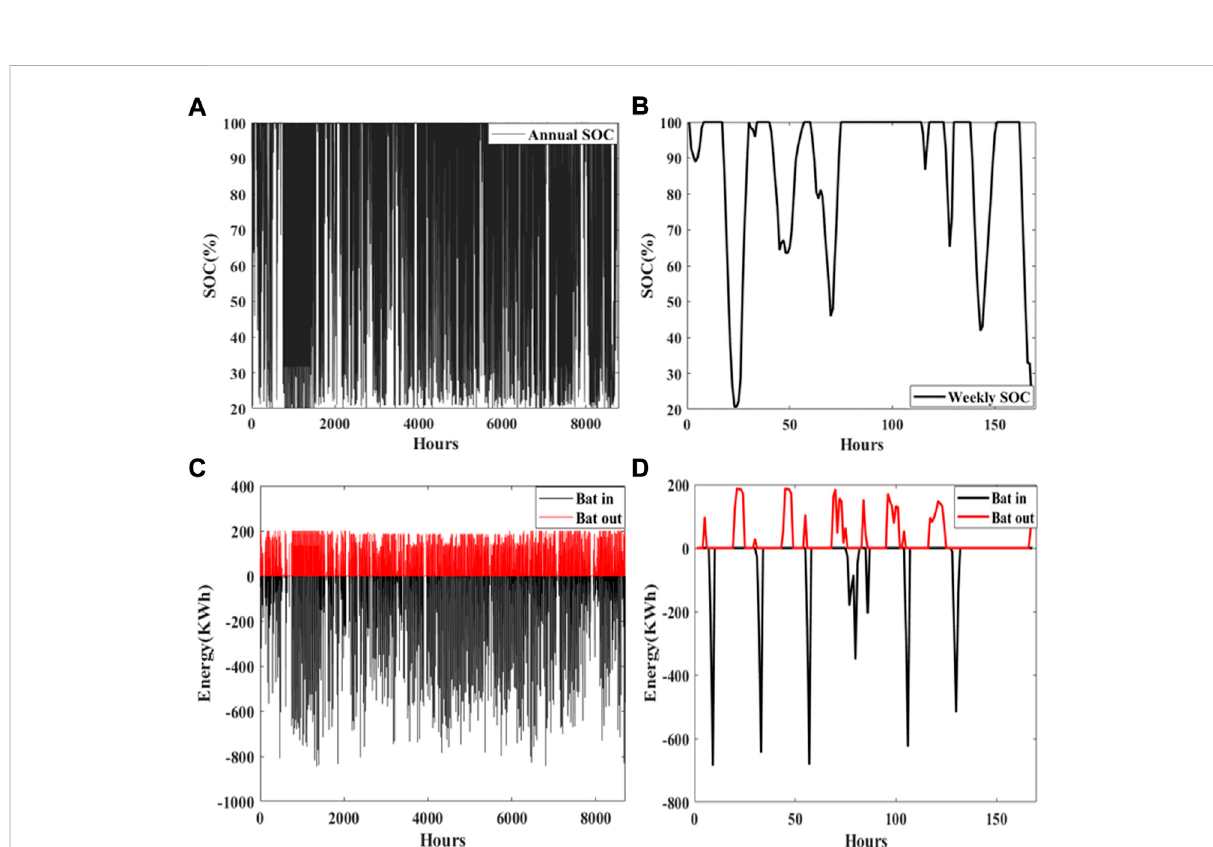
FIGURE 10 BatterySOCandenergy (A) annualSOC, (B) SOCofthe fi rstweekinMarch, (C) annualinputandoutputenergy,and (D) inputandoutputenergy of the fi rst week in